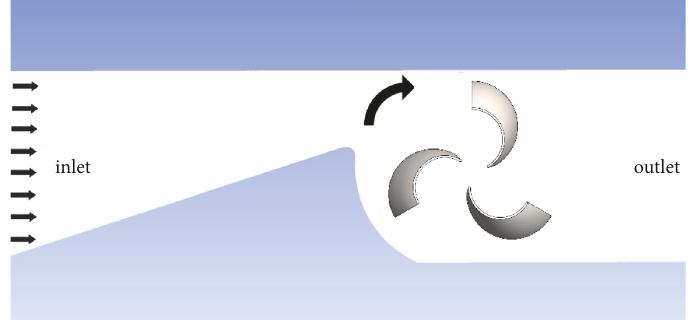
Figure 9: The position of the turbine blades for comparison.